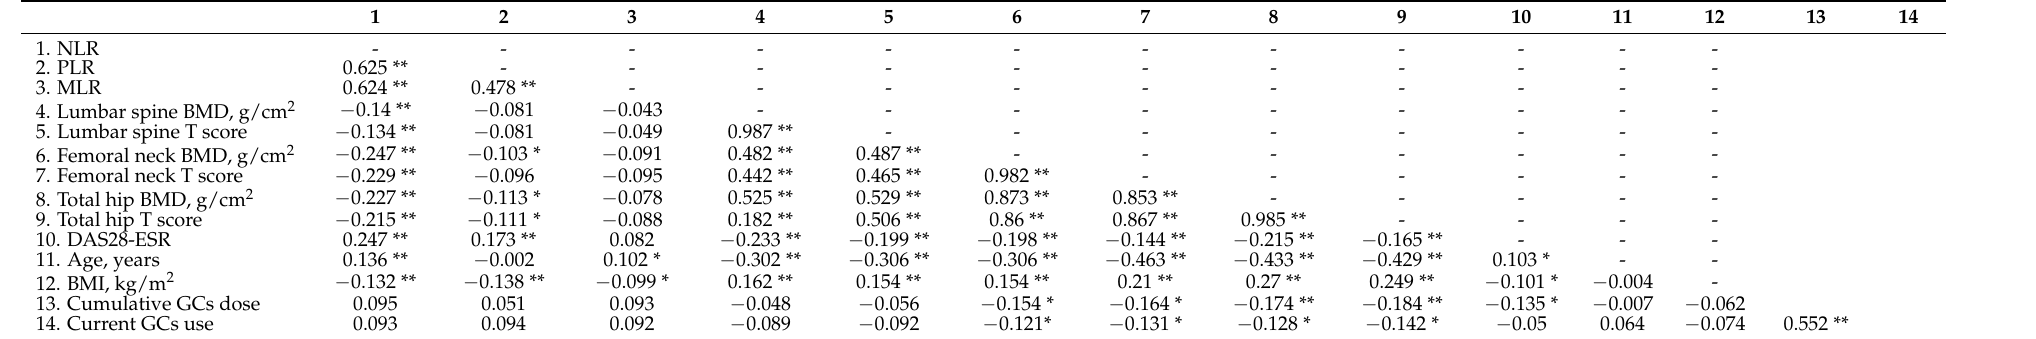
Table 3. Baseline disease characteristics in postmenopausal patients with rheumatoid